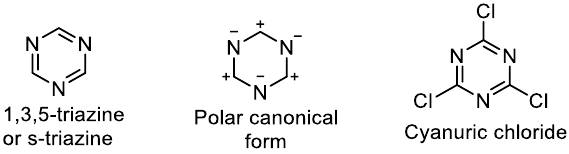
Figure 2. Molecular structure of triazine, its polar canonical form, and cyanuric chloride.